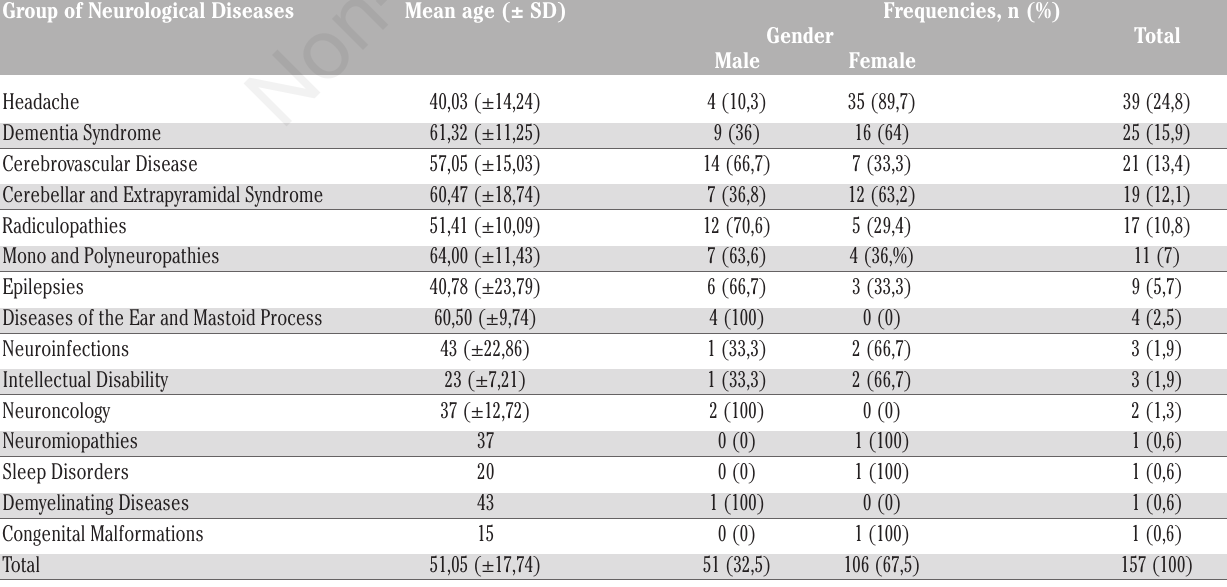
Table 3. Frequency of neurological syndromes by age group and gender. Group of Neurological